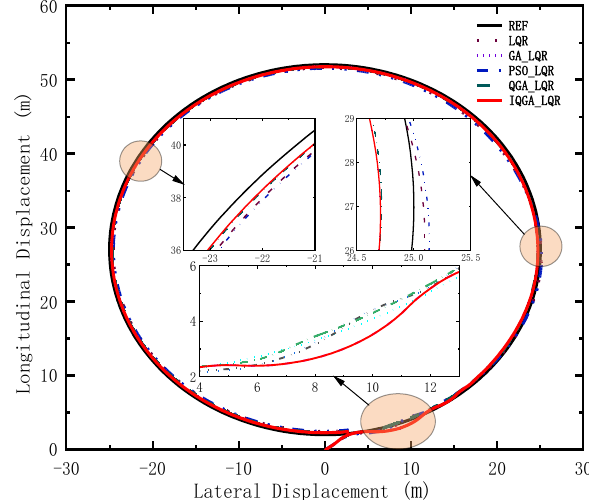
Figure 4. Reference trajectory and actual trajectory.